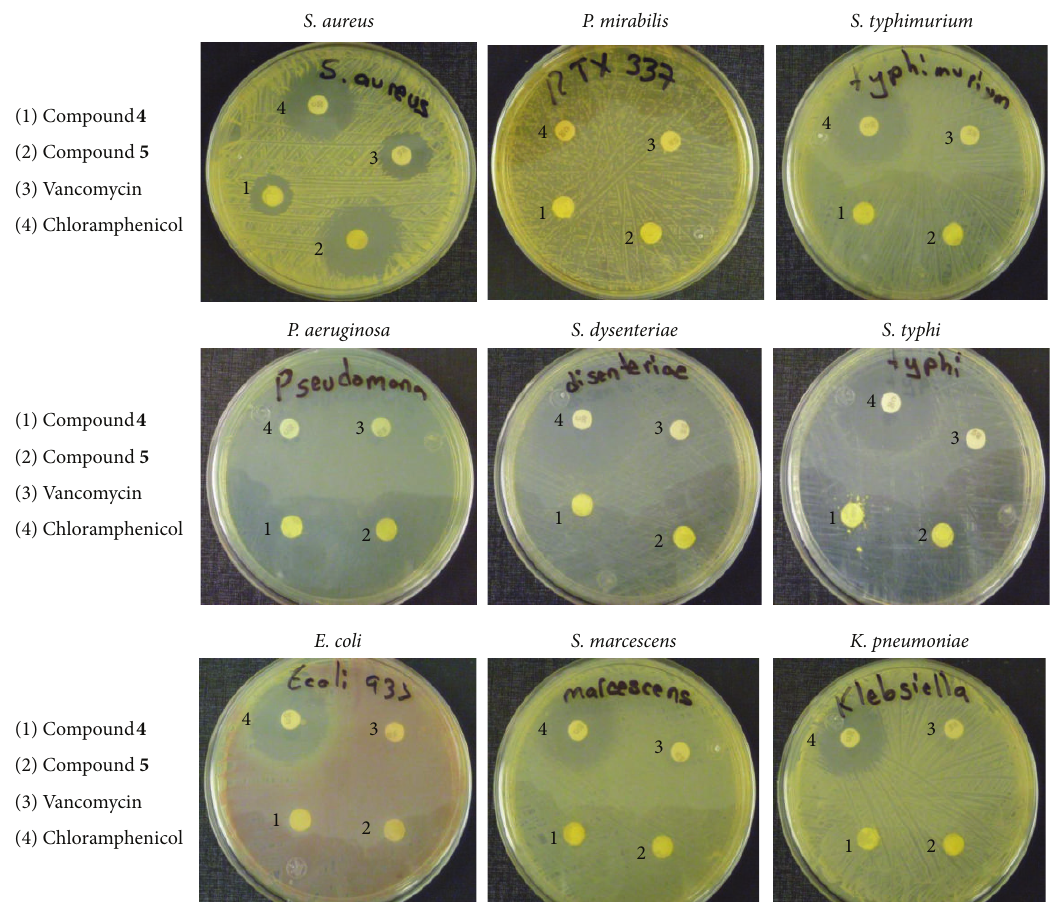
Figure 6: Photographs of the antimicrobial activities of compounds 4 and 5 against S. aureus , P. mirabilis , S. typhimurium , P. aeruginosa , S. dysenteriae , and S. typhi , showing their inhibition zone. Table 3: Antimicrobial activity of organotin(IV) compounds 1 – 5 .